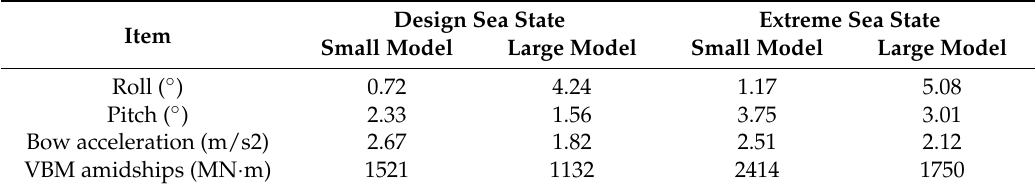
Table 6. Comparison of ship responses at full-scale.